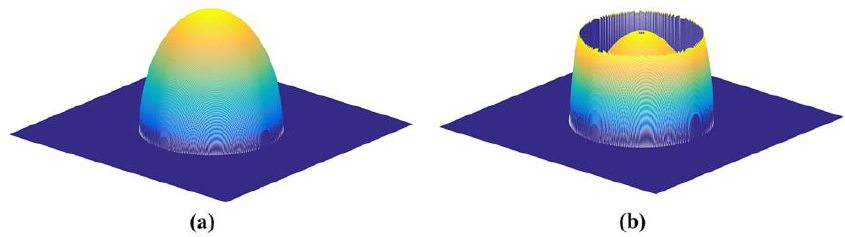
Figure 8. A 3D reconstruction of the hemisphere. ( a ) The proposed method; ( b ) An’s method.